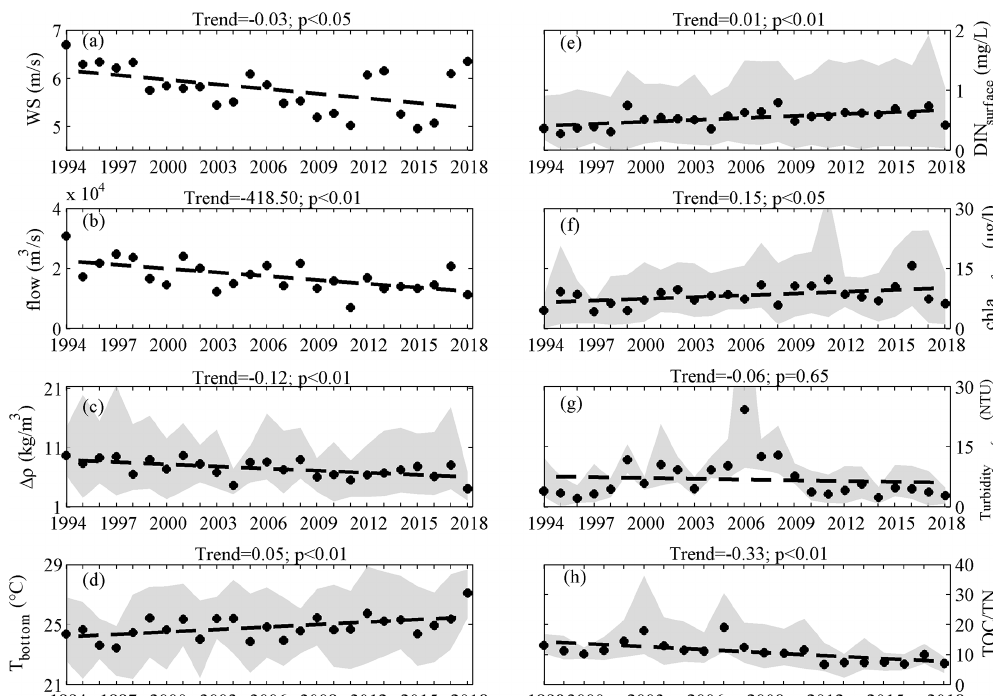
Figure 9. Long-term trends of the wind speeds (a) , freshwater discharges (b) , density differences (c) , bottom temperature (d) , surface DIN (e) , surface Chl a (f) , surface turbidity (g) , and TOC / TN measured in the sediments (h) in summer during 1998–2018. Note that the black dots represent the spatial average values of each variable and the gray patches represent the range of each variable observed in the 10 stations.